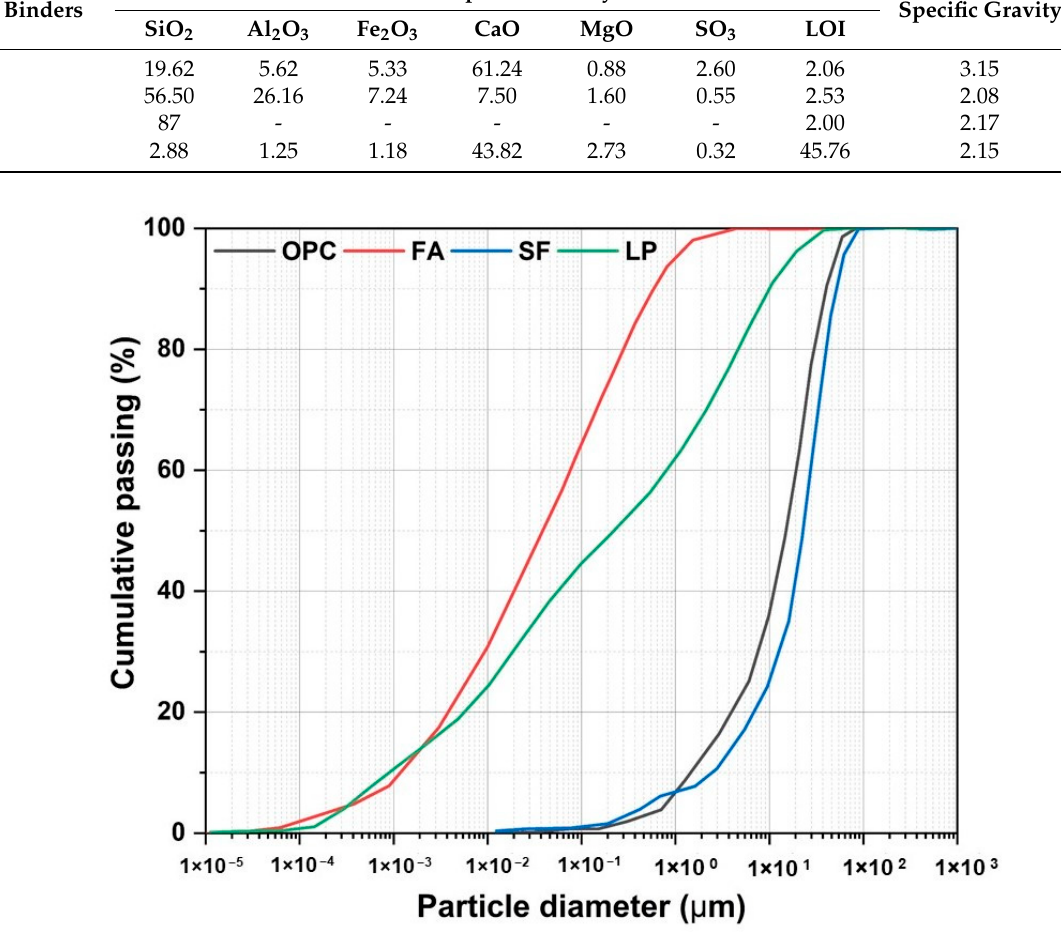
Figure 2. Particle size distributions of OPC, FA, SF and LP. Table 1. Chemical composition of binders.